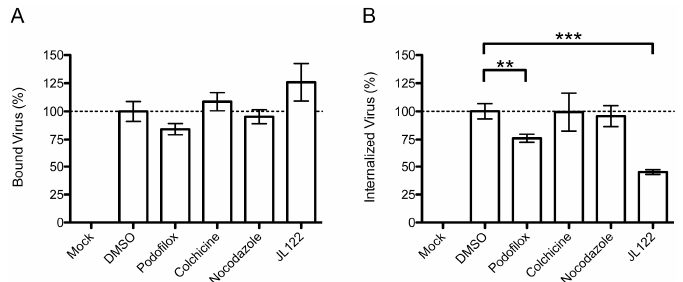
Figure 3. Podofilox inhibits CMV entry post binding. MRC5 cells or virus were pretreated with DMSO, podofilox (50 nM), colchicine (500 nM), nocodazole (5 μ M), and JL122 (250 nM) for 1 h (or virus was treated for 1 h in the case of JL122) and infected with AD169 WT for 2 h at either 4 °C ( A ) or 37 °C ( B ) and analyzed for the presence of viral DNA by qPCR; ( A ) Bound Virus (%) and ( B ) Internalized Virus (%) values were determined using the relative number of virus genomes (see Materials and Methods) from DMSO treated cells as 100%. Graph represents the average of three separate experiments each performed in triplicate, error bars correspond to standard error. ** p < 0.01, *** p < 0.001.